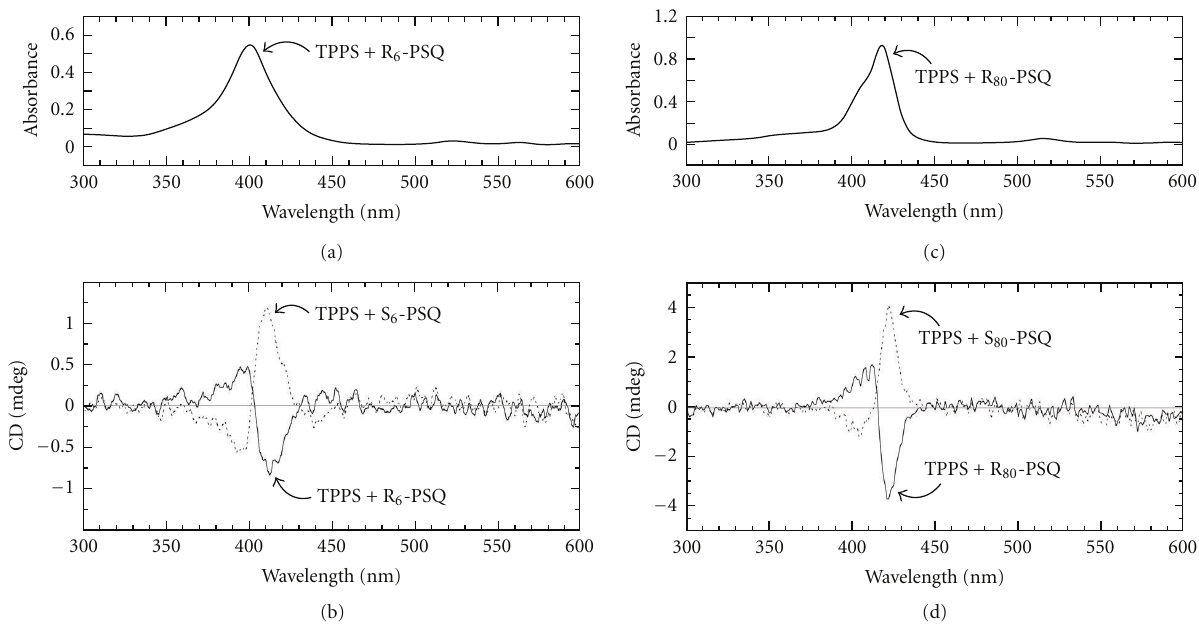
Figure 6: (a) UV-Vis spectrum of TPPS/R 6 -PSQ aqueous mixture, (b) ECD spectra of TPPS/R 6 - and S 6 -PSQs aqueous mixtures, (c) UV-Vis spectrum of TPPS/R 80 -PSQ mixture in methanol, and (d) ECD spectra of TPPS/R 80 - and S 80 -PSQs mixtures in